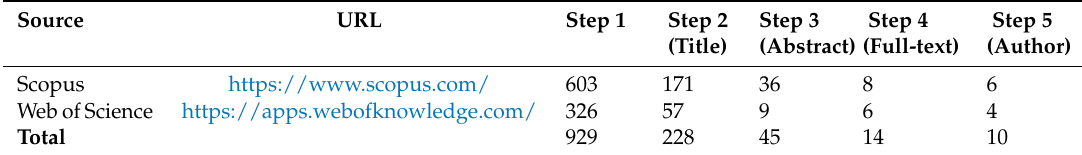
Table 2. Electronic databases and search engines used in the